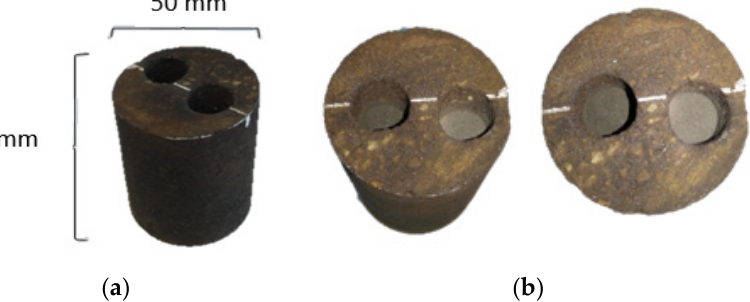
Figure 1. ( a ) Magnesia chromite drill core obtained from industrial refractory brick; ( b ) drill core perforations filled with a mixture of synthetic fayalite slag doped with clay minerals.